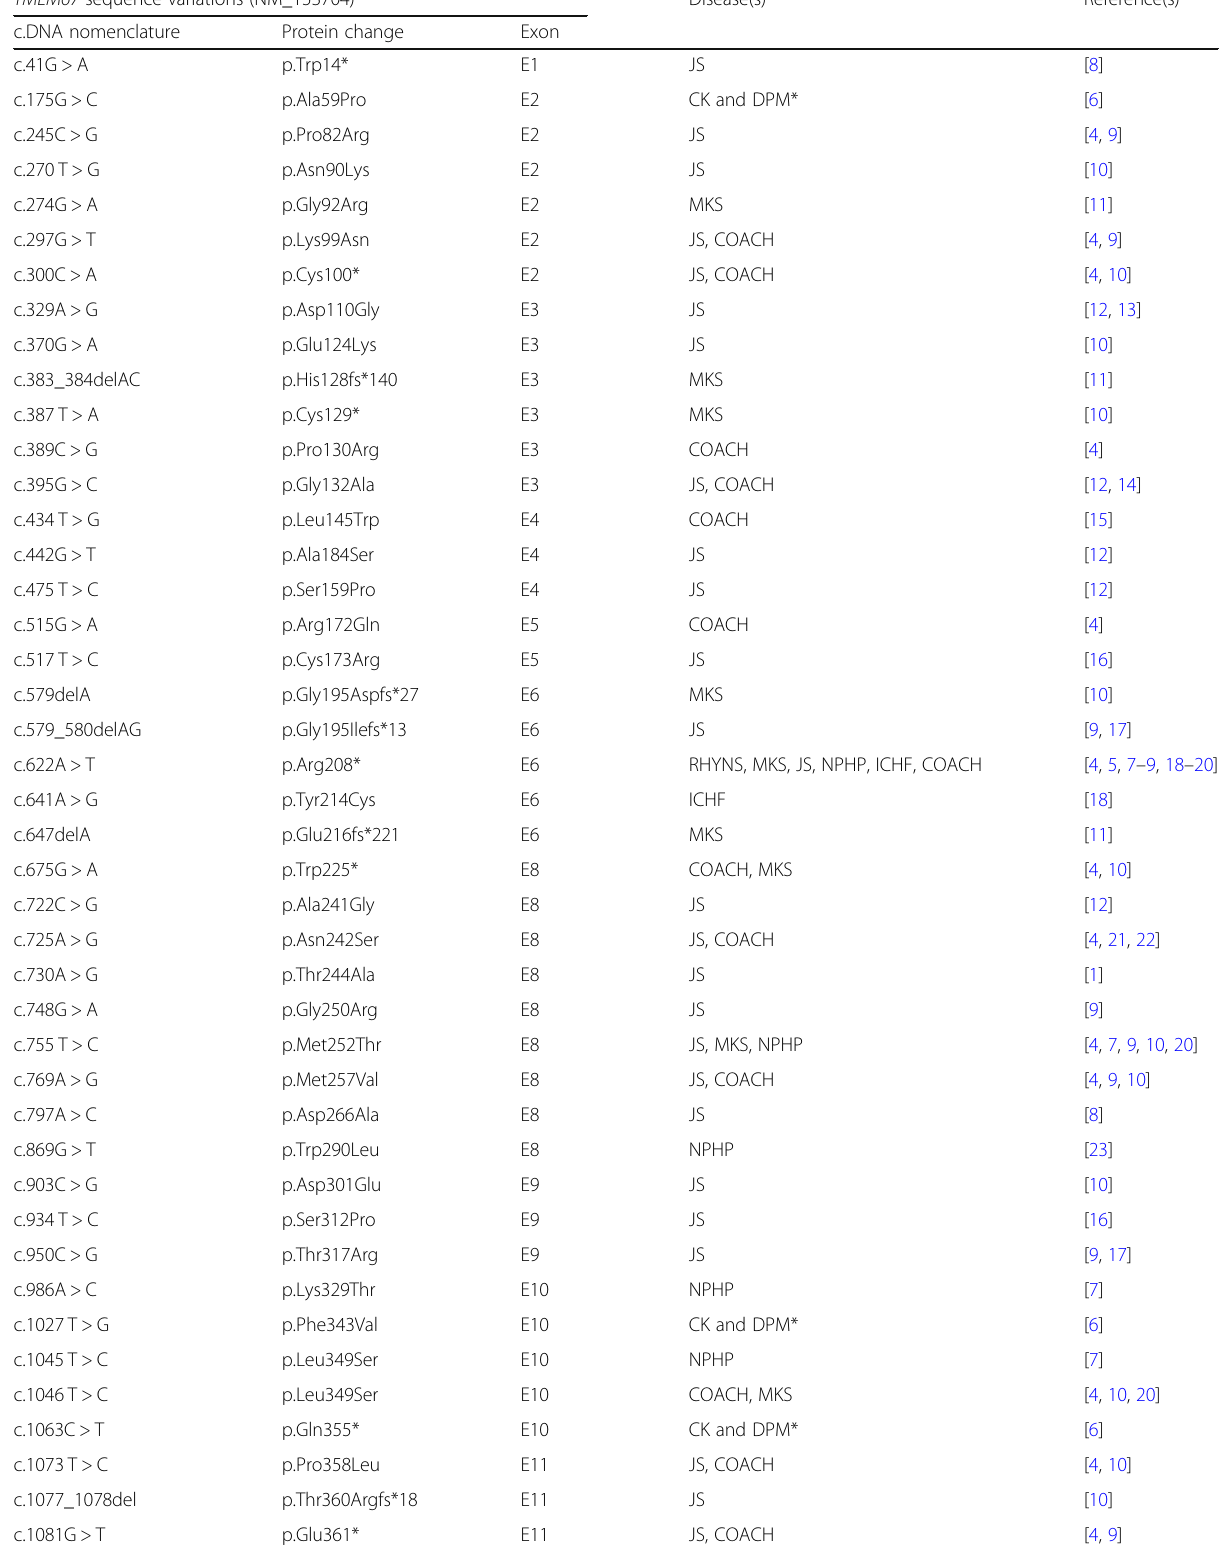
Table 1 TMEM67 sequence variations associated with a wide phenotype spectrum previously reported in the medical literature TMEM67 sequence variations (NM_153704)